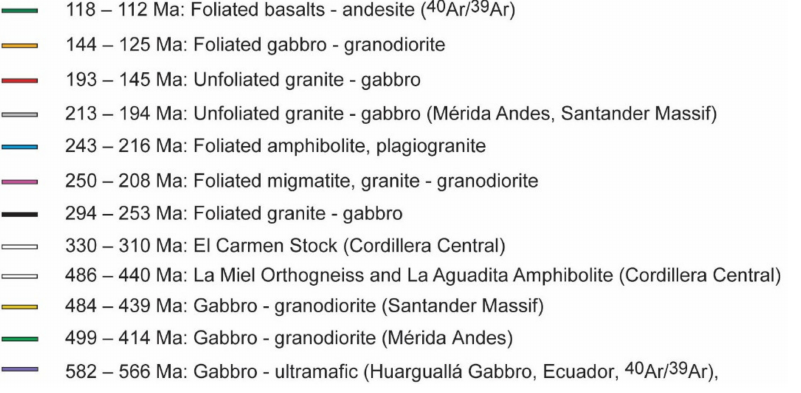
Figure 2. Histogram of crystallisation ages (mainly zircon 238 U- 206 Pb concordia ages) of igneous rocks in Venezuela, Colombia and Ecuador during 499–112 Ma. Data are from Litherland et al. (1994) [17], Noble et al. (1997) [37], Vinasco et al. (2006) [26], Colmenares (2007) [45], Montes et al. (2010) [30], Weber et al. (2010) [31], Leal-Mejia (2011) [19], Restrepo et al. (2011) [32], Villagomez et al. (2011) [7], Mantilla-Figueroa et al. (2012, 2013) [4,5], Riel et al. (2013) [35], Cochrane et al. (2014a, b) [21,46], Martens et al. (2014) [8], Van der Lelij et al. (2016) [2], Bustamante et al. (2010, 2016, 2017) [22,40,41], Paul et al. (2018) [23], Rodriguez et al. (2018) [42], Piraquive et al. (2021) [11], Restrepo et al. (2021) [44], Spikings and Paul (2019) [24], Spikings et al. (2015, 2019, 2021) [1,36,43], Tazzo-Rangel et al. (2019; orthogneisses only) [3].